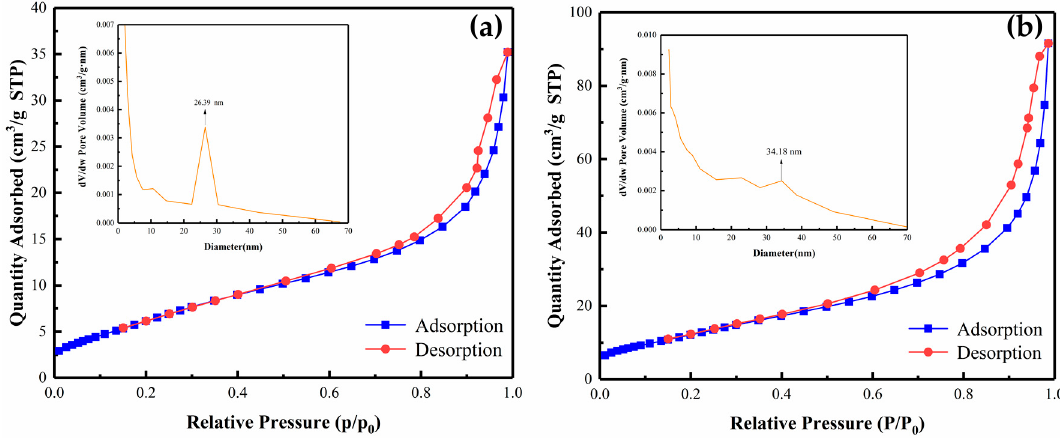
Figure 10. N 2 adsorption–desorption isotherms and the corresponding pore size distribution curves (inset) of the Bi 2 MoO 6 ( a ) and 1% S-doped Bi 2 MoO 6 ( b ).